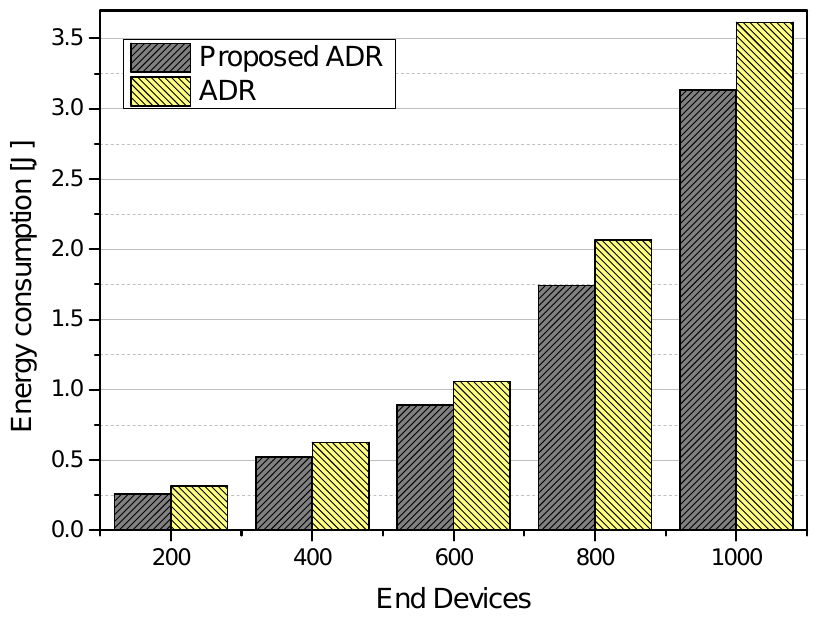
Figure 5. Average Energy Consumption in Joules for the Proposed ADR and